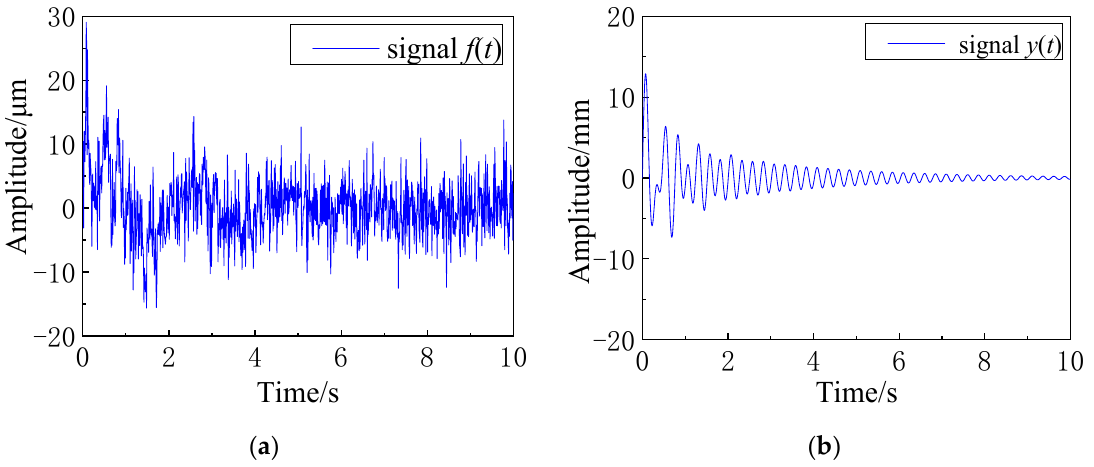
Figure 2. Time history comparison of noised signal f ( t ) and pure signal y ( t ) . ( a ) Time history of noised signal f ( t ) ; ( b ) Time history of pure signal y ( t )